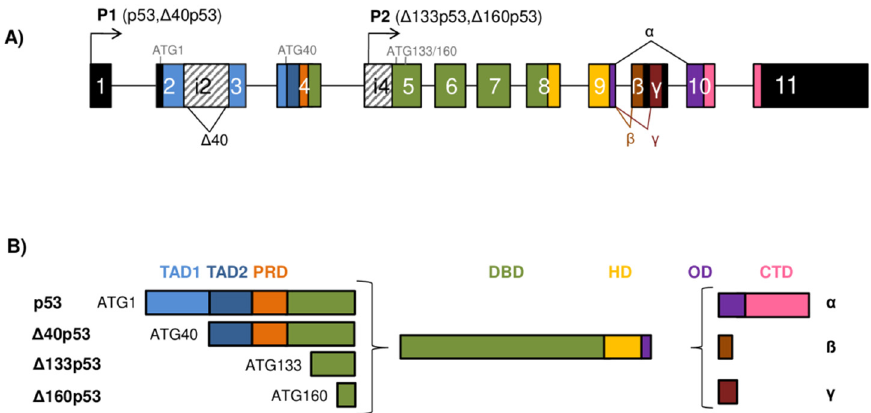
Figure 1. The TP53 gene architecture and generation of the p53 isoforms. ( A ) The scheme of the TP53 gene structure. The human TP53 gene consists of 11 exons and two alternative exons 9 β and 9 γ . The exons are shown as boxes of different colors and noncoding sequences in black. Introns 2 (i2) and 4 (i4) are shown as boxes with a striped pattern. The TP53 gene can be transcribed from two different promoters, the canonical promoter P1 upstream of exon 1 (giving rise to the long p53/ Δ 40p53 isoforms) and the alternative P2 located in intron 4 (giving rise to the short Δ 133/ Δ 160p53 isoforms). The TP53 mRNAs can be alternatively spliced at intron 2 or intron 9, producing isoforms with different N- and/or C-termini. There are four possible different start codons for mRNA translation (ATG1, ATG40, ATG133, and ATG160) resulting in protein isoforms of varying length. ( B ) Modular structure of the p53 protein isoforms. Functional protein domains are shown in different colors matching those used for the encoding exons of the TP53 gene in ( A ). The full-length p53 α protein consists of two transactivation domains (TAD1 and TAD2), a proline-rich domain (PRD), a DNA- binding domain (DBD), a hinge domain (HD), an oligomerization domain (OD), and a C-terminal domain (CTD). There are 12 distinct p53 protein isoforms differing in the composition of the structural domains. Model adapted from